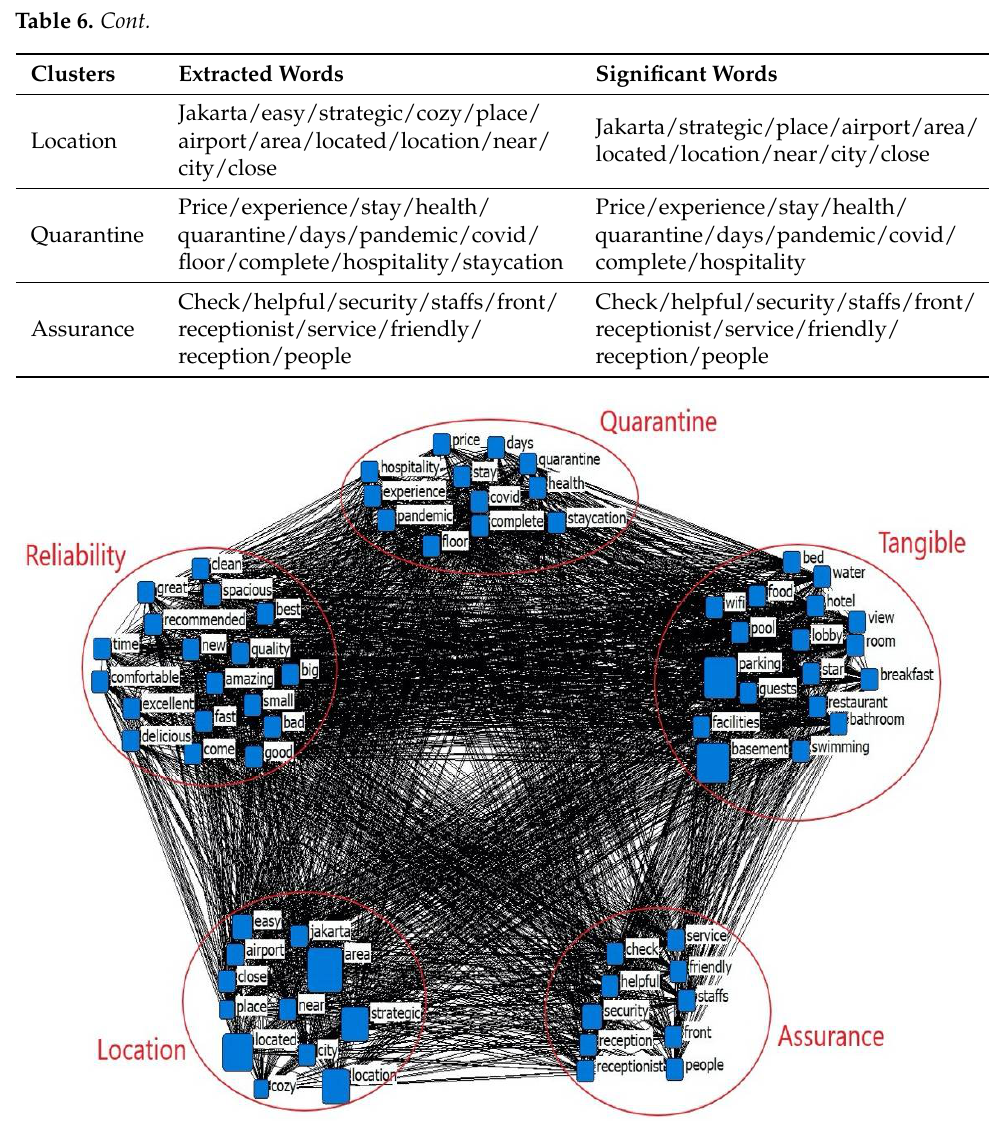
Figure 2. Visualization of CONCOR Analysis. Table 6. Clustering of CONCOR Analysis.